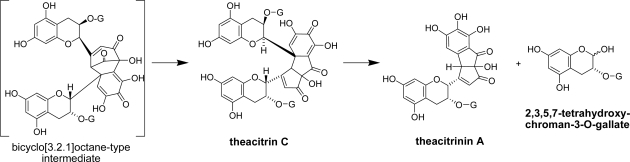
Production and decomposition of theacitrin C [42,43].